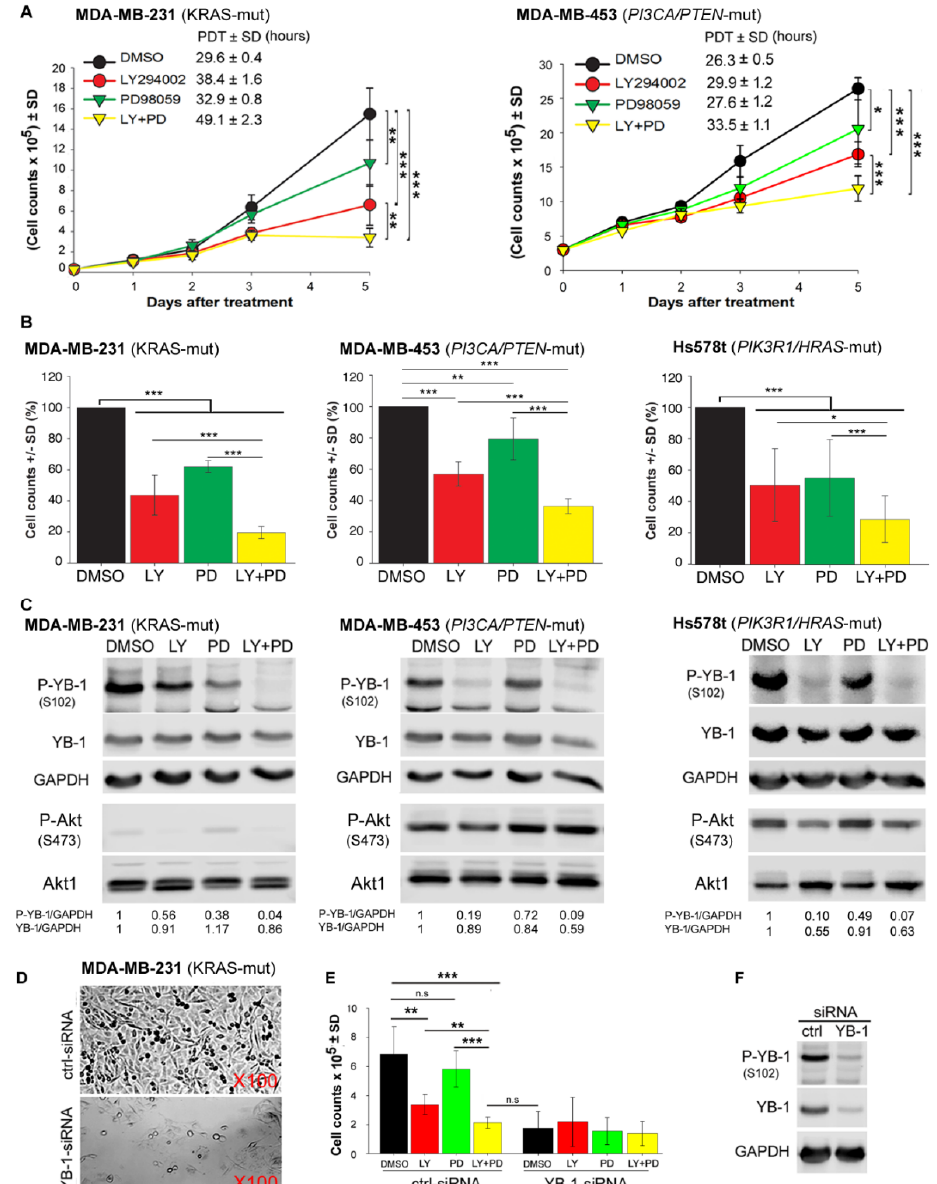
Figure 4. Dual targeting of PI3K and MEK is an efficient approach to block proliferation of KRAS -mutated TNBC cells (MDA-MB-231), PIK3CA / PTEN -mutated TNBC cells (MDA-MB-453), and PIK3R1/HRAS -mutated TNBC (Hs578t) cells in a YB-1-dependent manner. ( A ) A proliferation assay was performed after cell treatment with the PI3K inhibitor LY (10 µM), MEK inhibitor PD (20 µM), or a combination of both inhibitors in 6-cm plates (30 × 10 3 cells for MDA-MB-231 and 300 × 10 3 cells for MDA-MB-453). The concentration of vehicle (DMSO) was similar under all conditions, including the control (0.2%). Asterisks indicate significant differences in PDT between the indicated treatment conditions (* p < 0.05, ** p < 0.01, and *** p < 0.001, Student’s t -test; n = 6 data points, 2 experiments). ( B ) Cells were counted in the proliferation assay on day 5 after indicated treatments, mean percentage of cells was calculated for each inhibitor-treated condition and normalized to the DMSO-treated condition. Bar graphs present the mean of 9 data points from 3 independent experiments in MDA-MB-231 and MDA-MB-453 cells and 7 data points from 3 independent experiments in Hs578t cells. (* p < 0.05, ** p < 0.01, and *** p < 0.001, Student’s t -test) ( C ) Cells were treated as indicated, protein samples were isolated on day 5 after treatment, and the levels of indicated proteins were detected by Western blotting. Densitometry values represent the P-YB-1/GAPDH, YB-1/GAPDH ratios normalized to 1 in the DMSO-treated control. GAPDH was detected as the loading control. Experiments were repeated 3